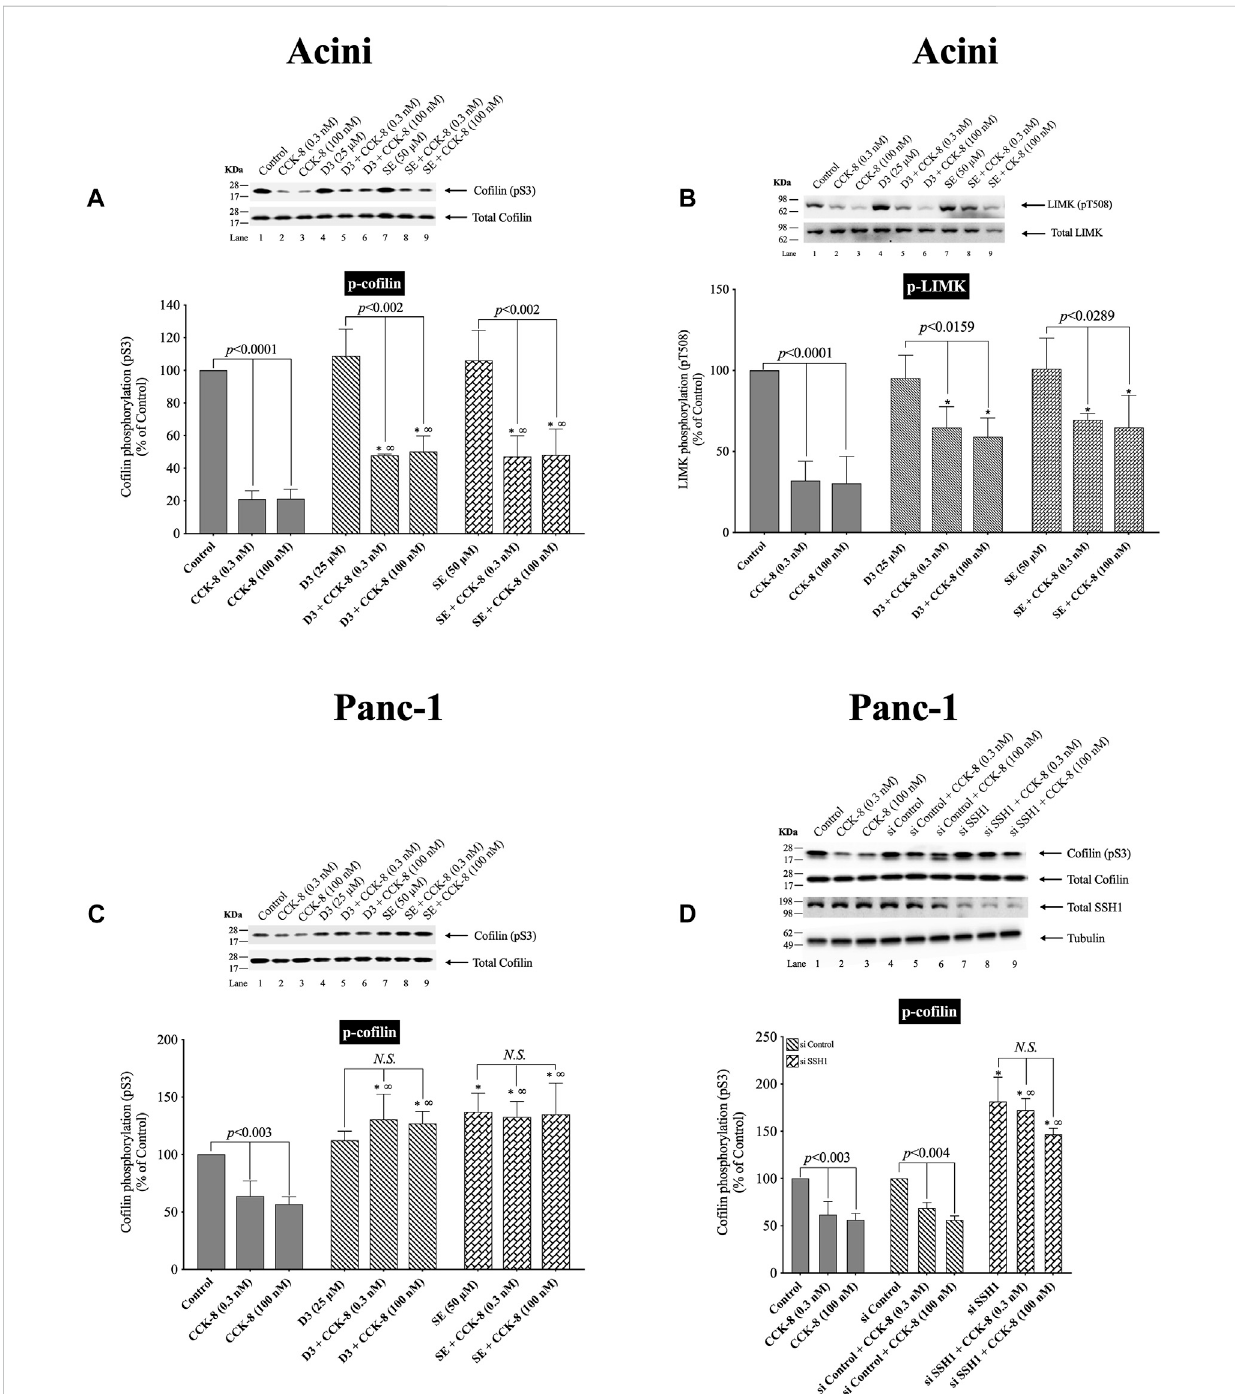
FIGURE 3 Effect of two SSH1 inhibitors, D3 and SE (A – C) , or SSH1 siRNA (D) , on the ability of CCK-8 (0.3 and 100 nM) to activate LIMK and co fi lin in pancreatic acini (A/B) andactivateco fi lininCCK 1 -R/Panc-1cells( C/D) .In (A/B) isolatedpancreaticaciniwereincubatedintheabsenceorpresenceofD3(25 µM)for 1 h or SE (50 µM) for 3 h and then incubated with no addition (control) or CCK-8 (0.3 and 100 nM) for 5 min, and then lysed. In (C) , CCK 1 -R/Panc-1 cells were incubated in the absence or presence of D3 (25 µM) for 1 h or SE (50 µM) for 24 h and then incubated with no addition (control) or CCK-8 (0.3 and 100 nM) for 5 min and then lysed. In (D) , CCK 1 -R/Panc-1 cells were transfected with siRNA non-targeting Control and siRNA against SSH1 for 48 h, and then incubated with no addition (control) or CCK-8 (0.3 and 100 nM) for 3 min and then lysed. Western blots were analyzed using anti-pS3 co fi lin and anti-pT508 LIMK3, and the knockdown effect of SSH1 was con fi rmed by Western blots using SSH1 (C-term) antibody. Bands were visualized using chemiluminescence and quanti fi ed by densitometry. Top : Results of a representative blot of four independent experiments are shown. Bottom : Means ± S.E. of at least 4 independent experiments. Results are expressed as % of basal stimulation of the control group. *, p < 0.05 compared to the control group; ∞ , p < 0.05 compared to stimulants without inhibitors. N.S. , No signi fi